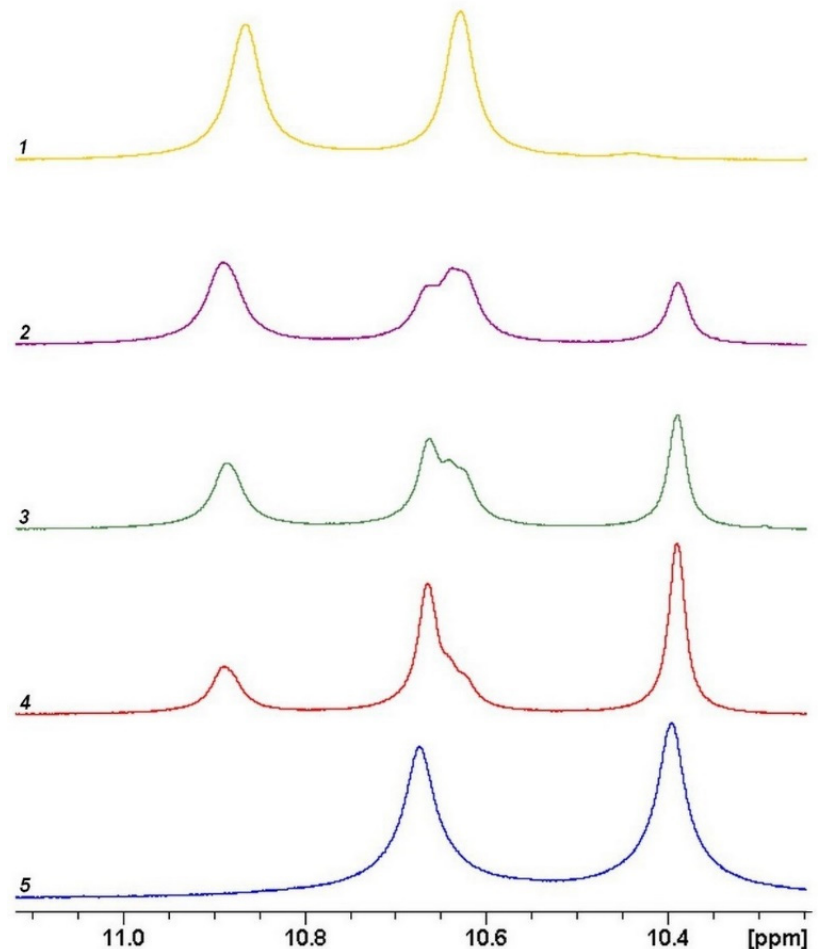
Figure 3. Portions of 1 H NMR spectra of PAIs containing the signals attributed to CONH-groups (proton labels in Figure 2). (1) yellow—PAI-2, (2) violet—coPAI-3, (3) green—coPAI-2, (4) red—coPAI-1, (5) blue—PAI-1.